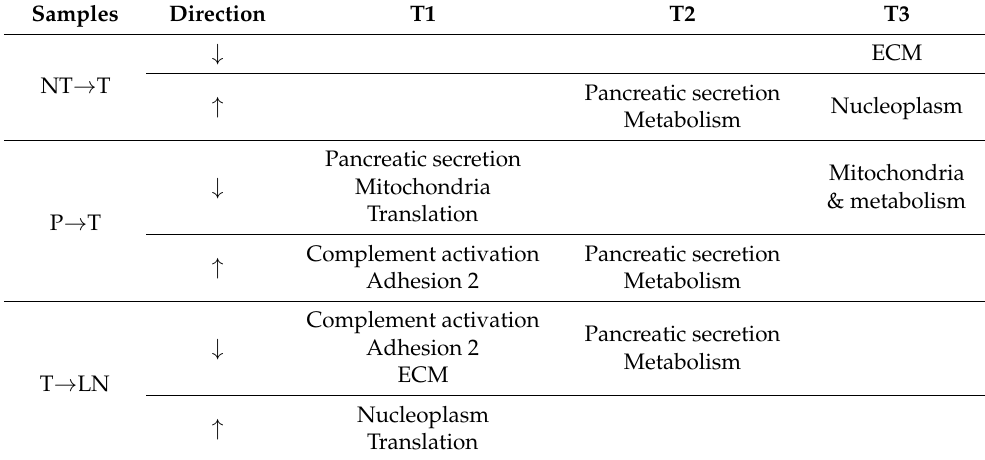
Table 2. Summary of functional node activities identified as differential using mixed linear models between samples in each PDAC proteomics subtype. NT = no tumor tissue, P = preneoplastic lesions, T = primary tumor, LN = lymph node metastasis.